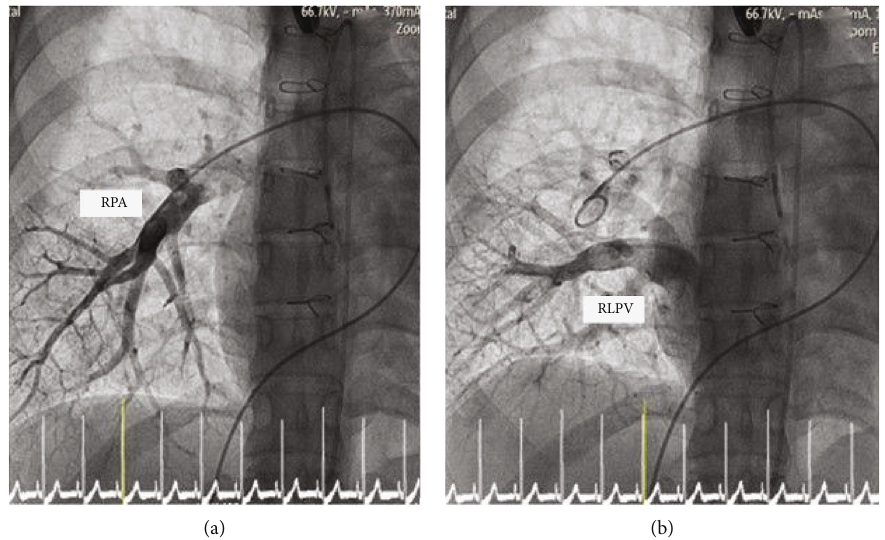
Figure 7: The (a) arterial phase and (b) levo phase of right pulmonary artery (RPA) angiography shows drainage of the right lower pulmonary vein (RLPV) into the right